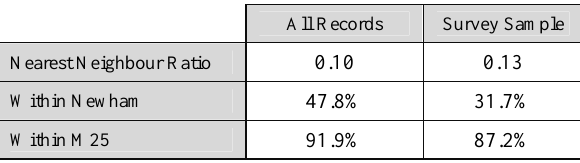
Table 5. Assessing Survey Sampling Bias